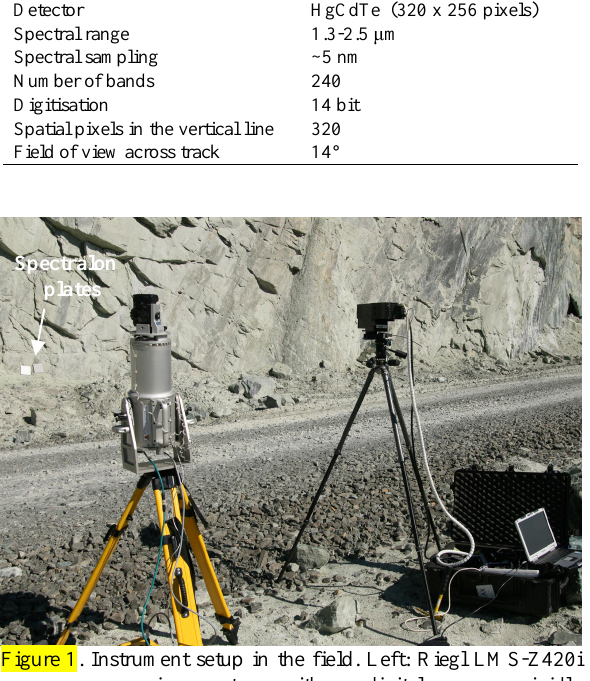
Figure 1. Instrument setup in the field. Left: Riegl LMS-Z420i scanning system with a digital camera rigidly mounted on top of the sensor; Right: HySpex SWIR-320m camera mounted on a rotation